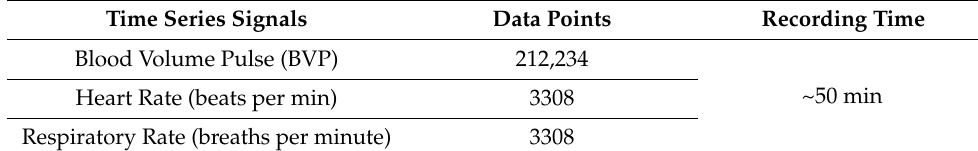
Table 2. The average number of entries (per participant).